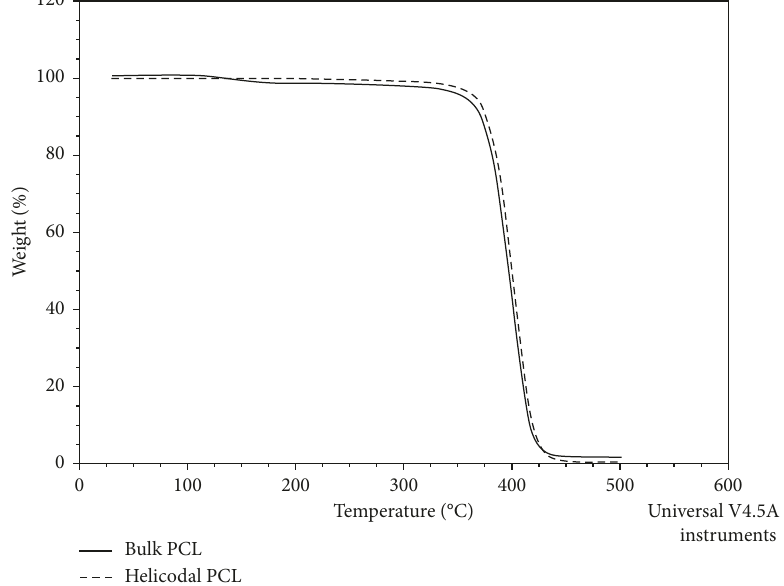
Figure 7: TGA curves of bulk and helicoidal